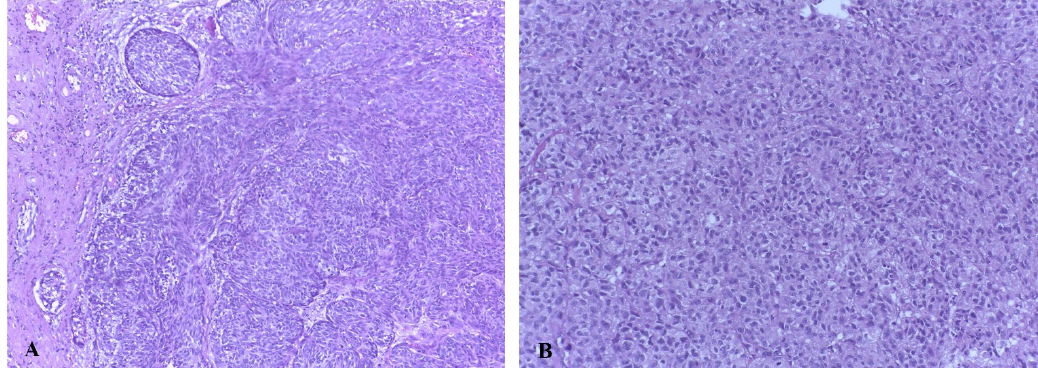
Figure 3. Vaginal melanoma. Vaginal squamous epithelium with areas of ulceration. In lamina pro- pria one can observe tumoral cells organized in nests. Hematoxylin-eosin stain, original magnifica- tion ×4 (histological image courtesy of dr. Ileana Popa).